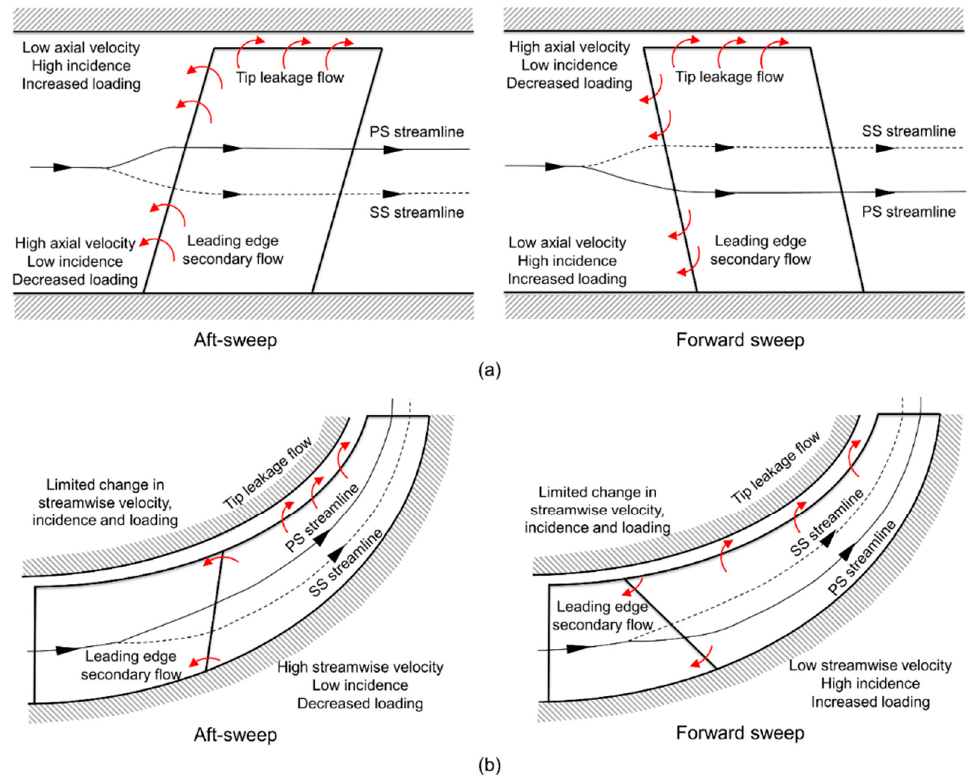
Figure 16. Understanding sweep effects on the front loading of ( a ) axial compressors and ( b ) centrifugal compressors through streamline twist.